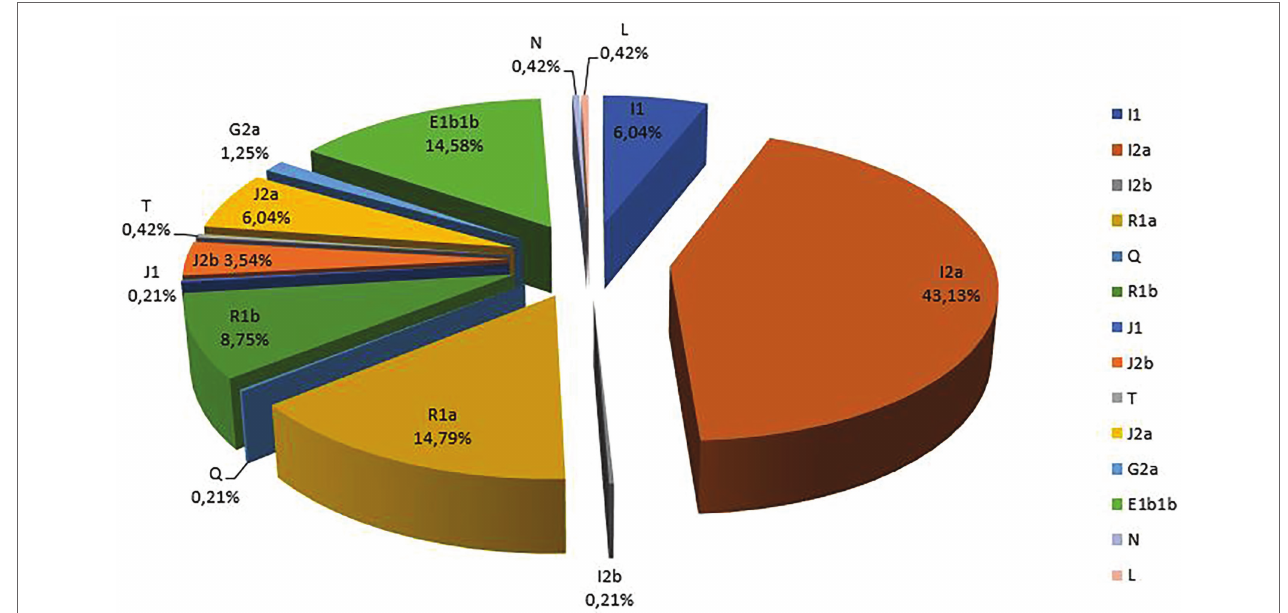
FIGURE 2 | Prevalence of Y-chromosomal haplogroups in the population of Bosnia and Herzegovina ( n =